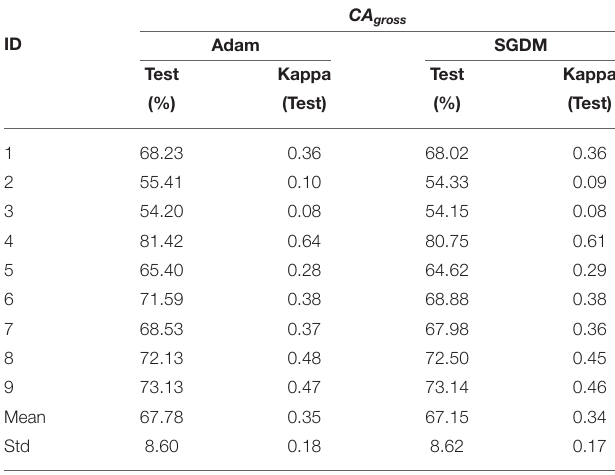
The CA gross for inter-subject transfer learning is shown